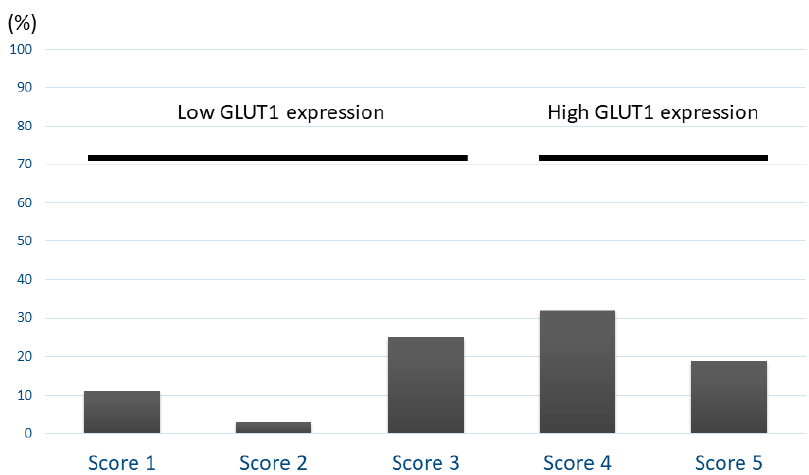
Figure 2. Distribution of GLUT1 expression according to scoring system. The frequencies of scores 1, 2, 3 4, and 5 for GLUT1 were 11%, 3%, 25%, 32%, and 19%, respectively.